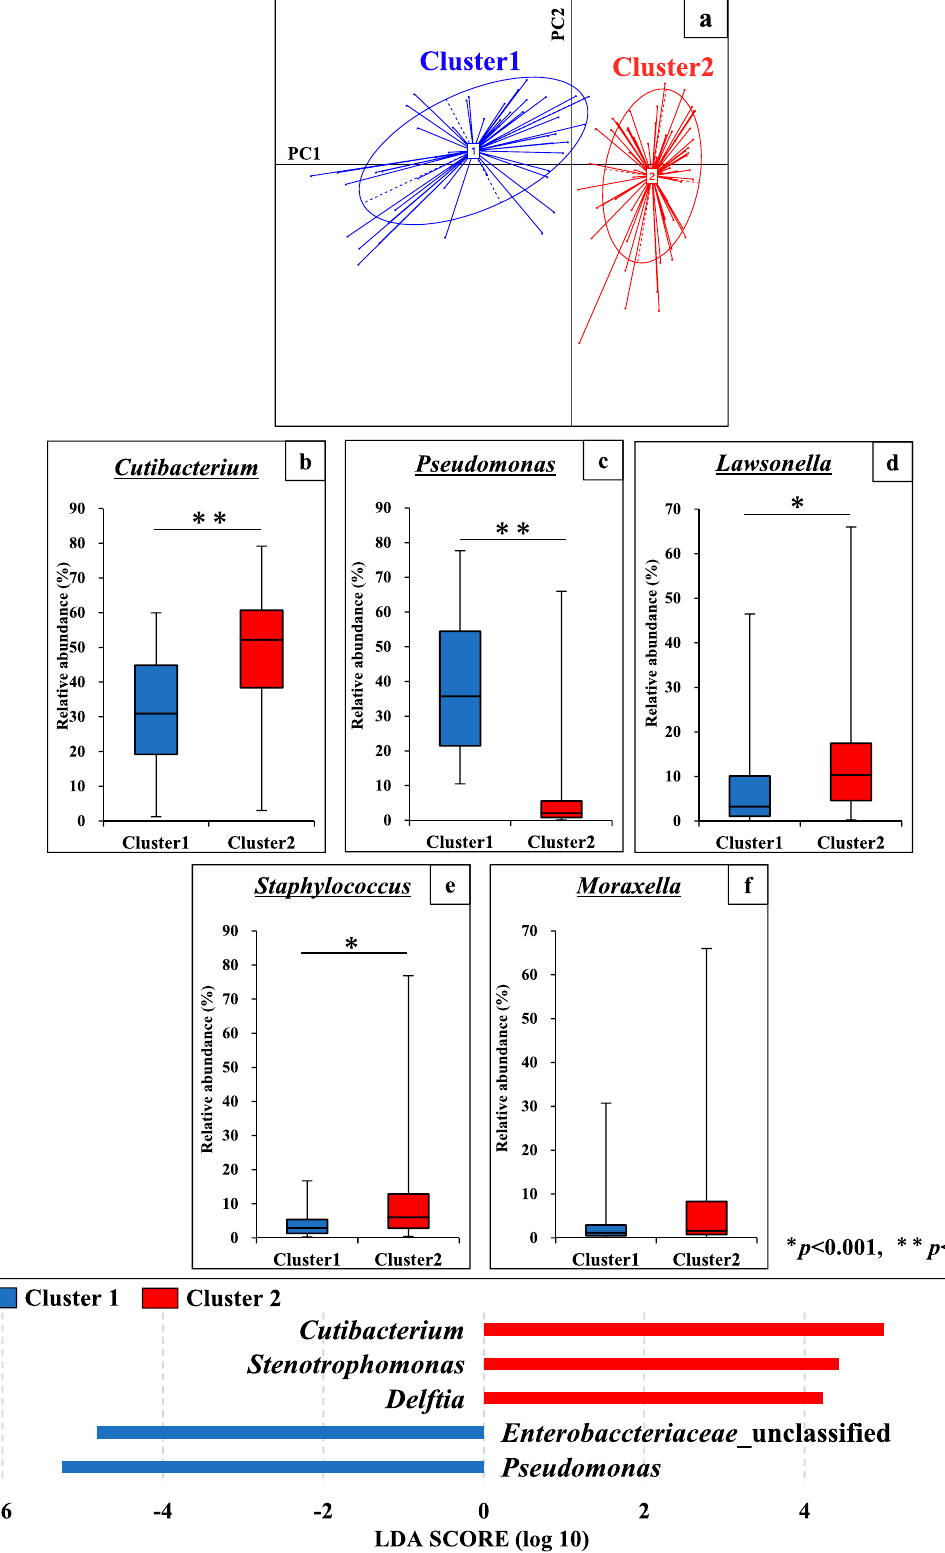
Figure 3. Analysis of bacterial community structure in scalp hair shaft samples at genus level. ( a ) Clustering of the 109 volunteers in principal component analysis at the genus level. The 109 samples were clustered using the partition around medoids (PAM) clustering. The two clusters were divided into a PC1-negative region (cluster 1) and a PC1- positive region (cluster 2). ( b – f ) Comparison of relative abundance of major five genera between cluster 1 and cluster 2 in scalp hair shaft samples. ( g ) Histogram of the Linear discriminant analysis (LDA) scores computed for microbial genera differentially abundant between cluster 1 and cluster 2 in scalp hair shaft